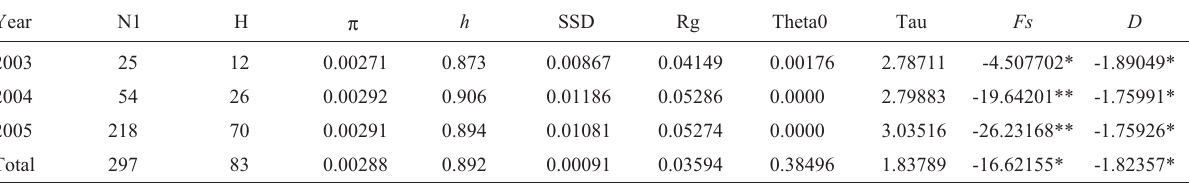
Table 2 - Parameters of D-loop diversity, mismatch analyses and mutation neutrality tests for each year in Cynoscion acoupa from the northern coast of